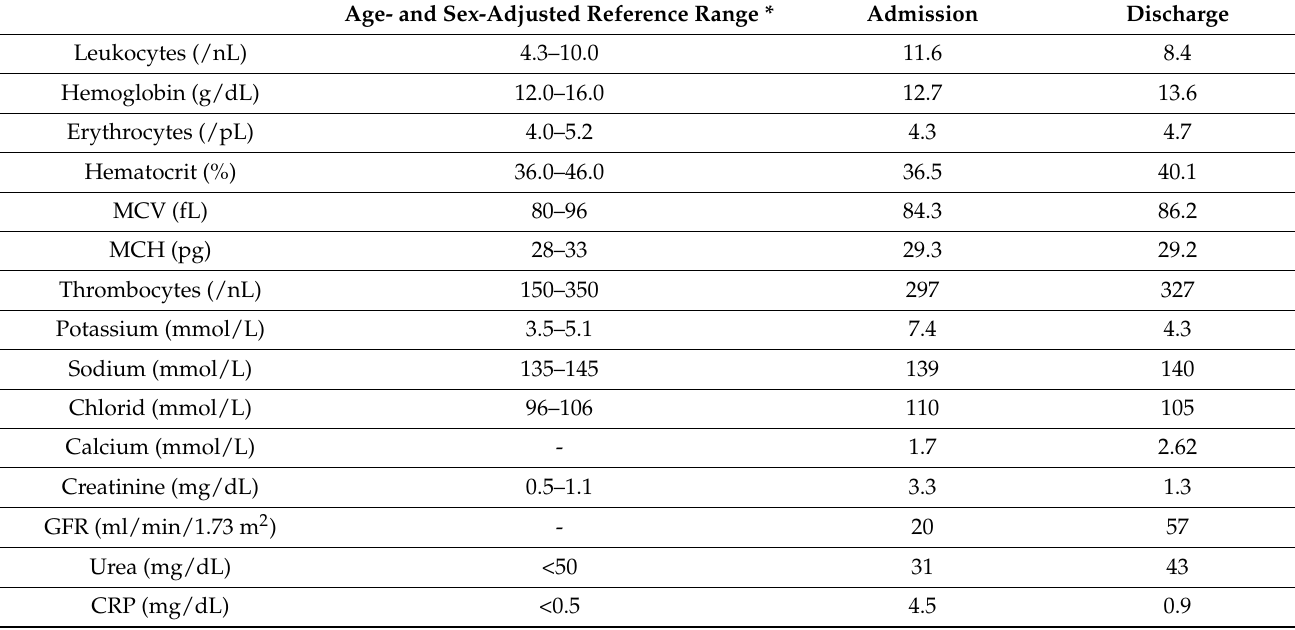
Figure 4. An ultrasonography of the kidneys of Case II ◦ . Both kidneys presented mild echogenic accentuation of the parenchyma with consecutive increased corticomedullary differentiation. Table 3. Laboratory findings from Case II ◦